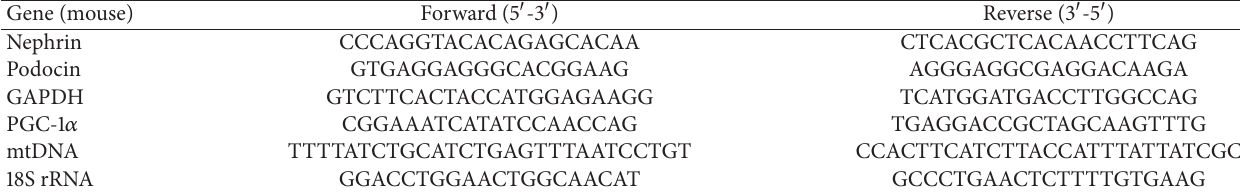
Table 2: Primer sequences of mouse for real-time